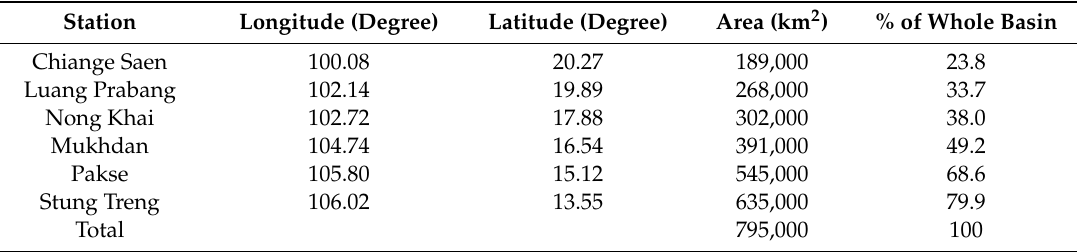
Table 2. The hydrological stations used for the Soil and Water Assessment Tool (SWAT) model’s calibration.